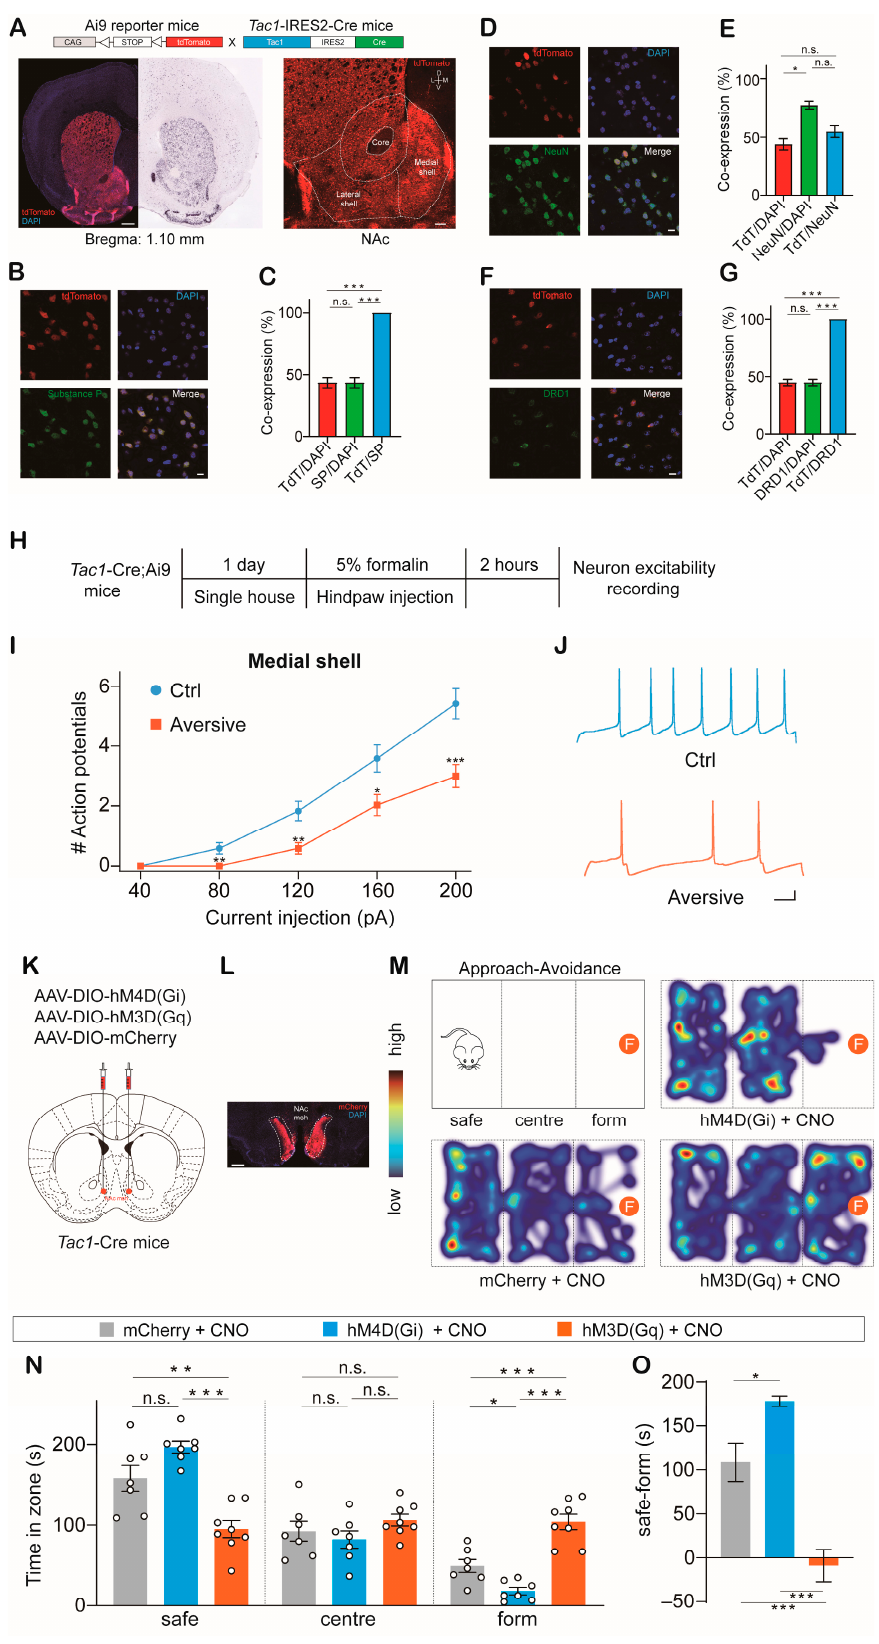
Figure 1. NAc Tac1 neurons mediate aversive behaviors: ( A ) Coronal images demonstrating the application of Tac1-IRES2-Cre and Ai9-tdTomato reporter mice to label Tac1-positive neurons in the NAc, compared to the Allen Institute for Brain Science. Scale bar: 500 µm and 100 µm, respectively.